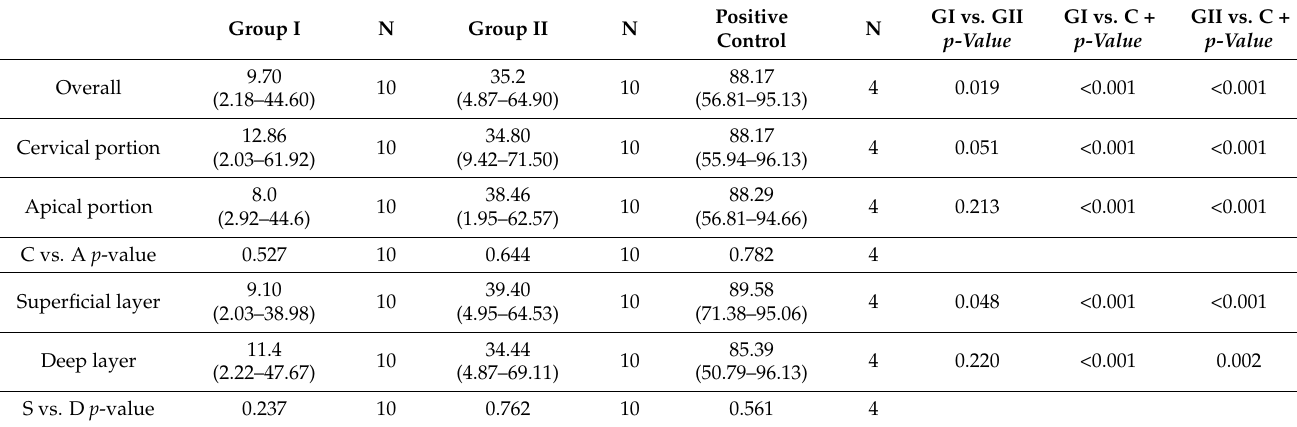
Table 2. Percentage of viable bacteria in different